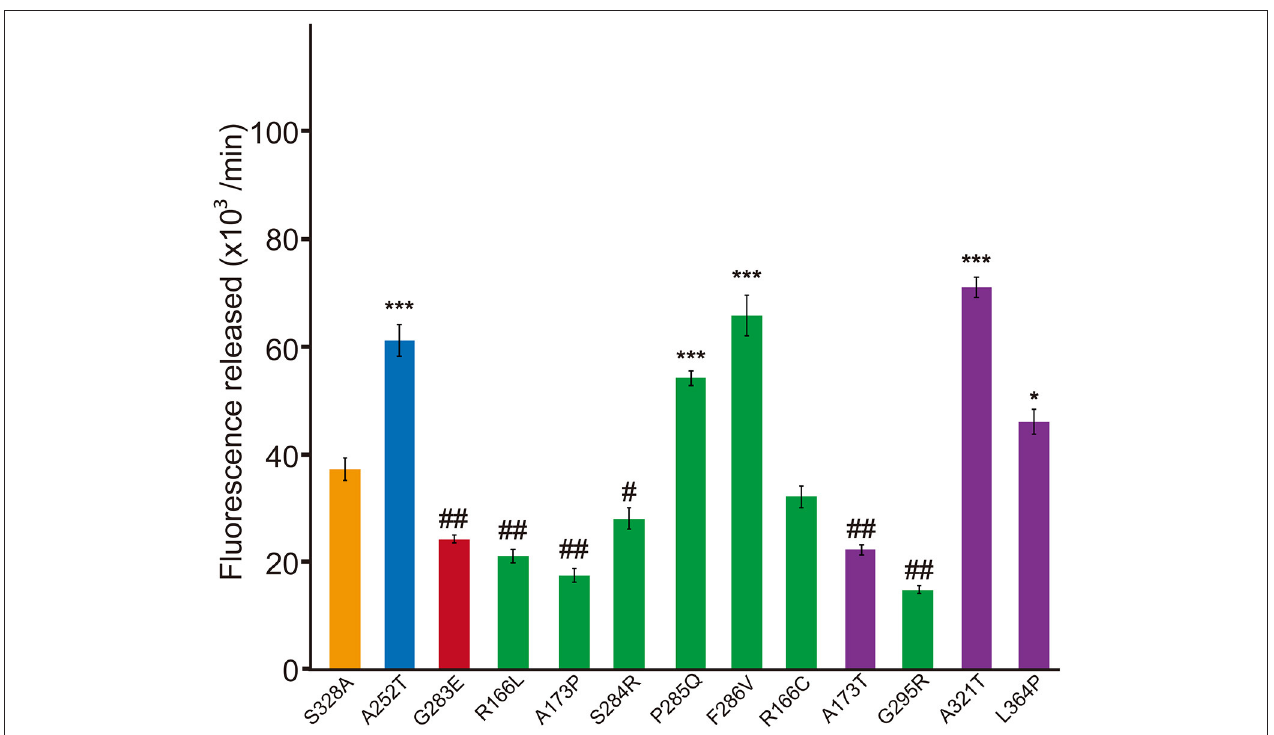
FIGURE 3 | Dominant-negative effects of missense HTRA1s identified in symptomatic carriers. Protease activities of mixtures of each missense HTRA1 with WT calculated from the slope of the linear portion of normalized fluorescence vs. time (30, 60, and 90min) plots. Orange, S328A/WT, a positive control for a dominant-negative effect. Blue and red bars indicate protease activities of A252T/WT and G283E/WT, respectively, negative and positive controls for dominant-negative effect, respectively. Green bars, missense HTRA1s identified in symptomatic carriers. Purple bars, missense HTRA1s found only in CARASIL patients. I-bars indicate standard errors (SE). Statistical comparisons of protease activities between each mutant HTRA1/WT and S328A/WT were performed with one-way analysis of variance followed by Dunnett’s post hoc test. *** P < 0.0001; * P < 0.05 for increases in protease activities for each HTRA1/WT relative